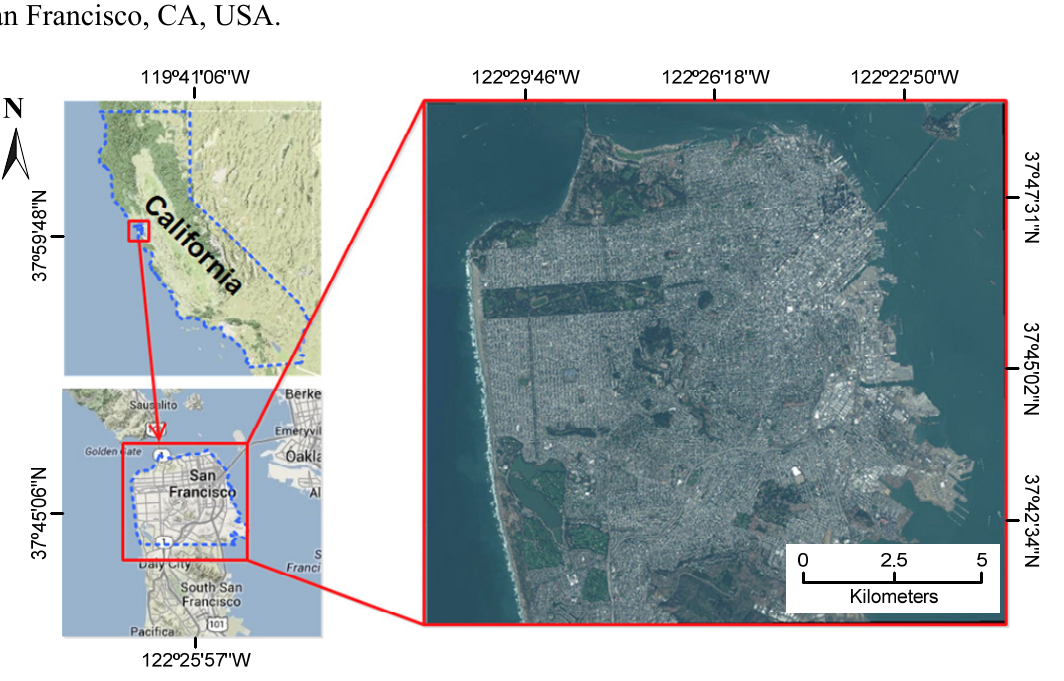
Figure 15. RGB composition in the visible spectrum of Worldview-2 image covering